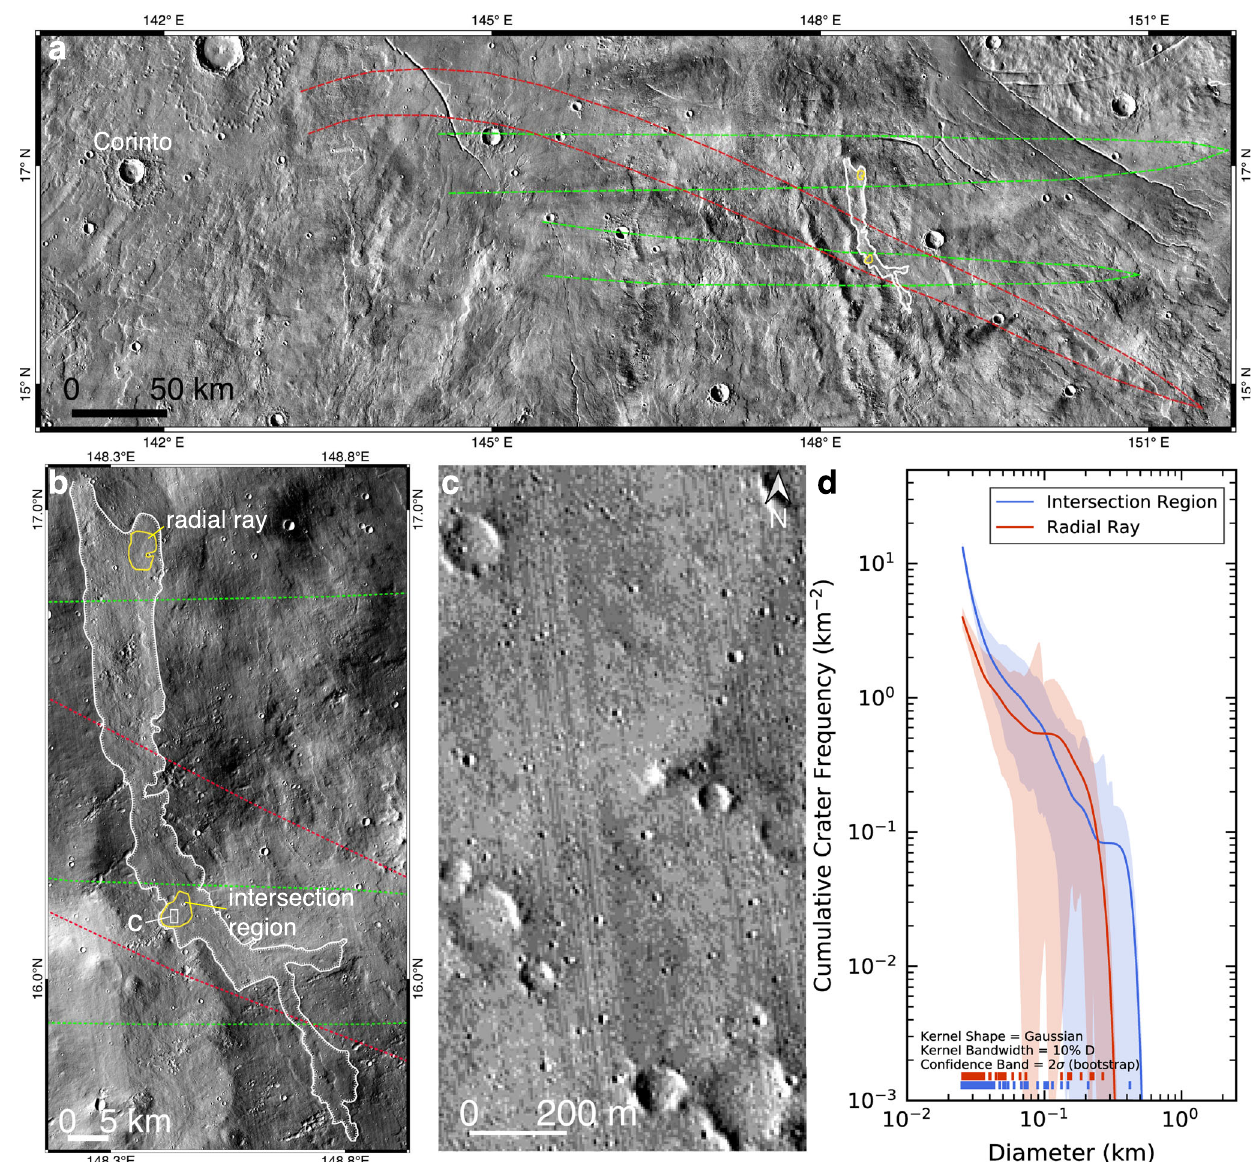
Fig. 10 | Distal ejecta formed by a same crater may exhibit overlapping rela- tionshipatasamesite.a , b TheCorintocrateronMars( D =13.7km)formedboth radial (green curves) and non-radial (red curves) distributions of secondaries, and some of them cross the same region (Supplementary Fig. 7a) 51 . A long lava fl ow (whitecurves)crossestheintersectionregionoftworaysofsecondariesformedby the Corinto crater. The yellow polygons are two counting areas on the lava fl ow, where crater densities are measured and compared. c Morphology of impact